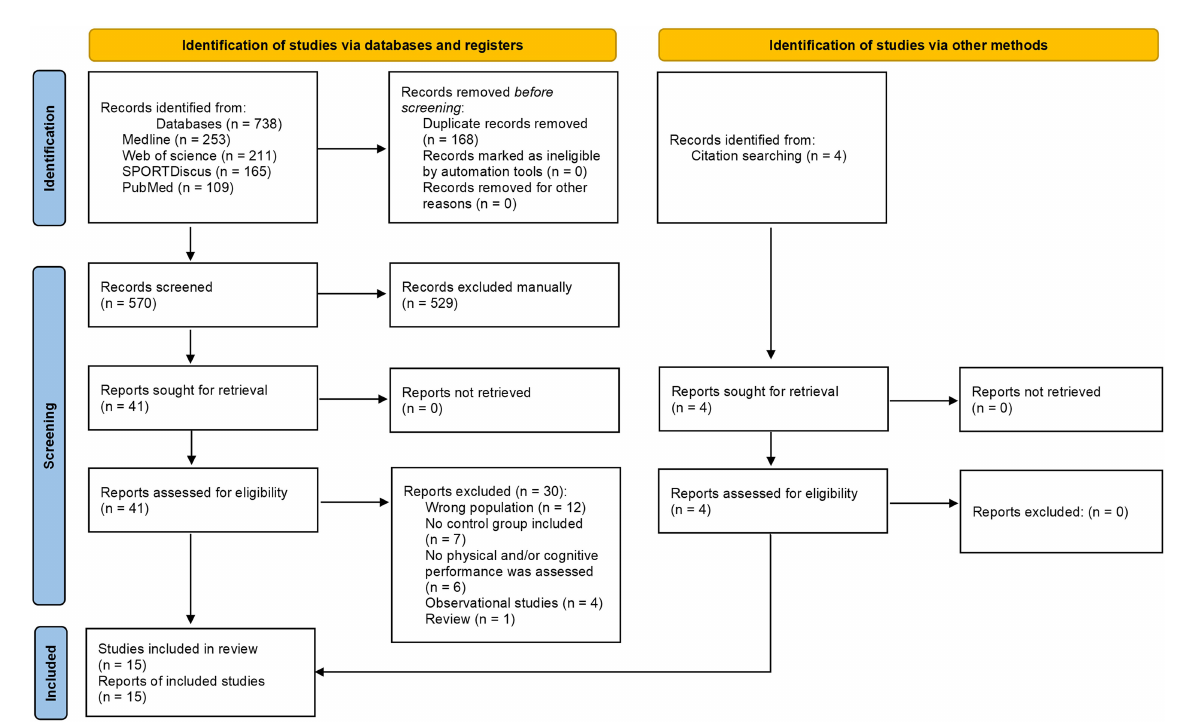
FIGURE1 PRISMA 2020 flow diagram for new systematic reviews which included searches of databases, registers and other